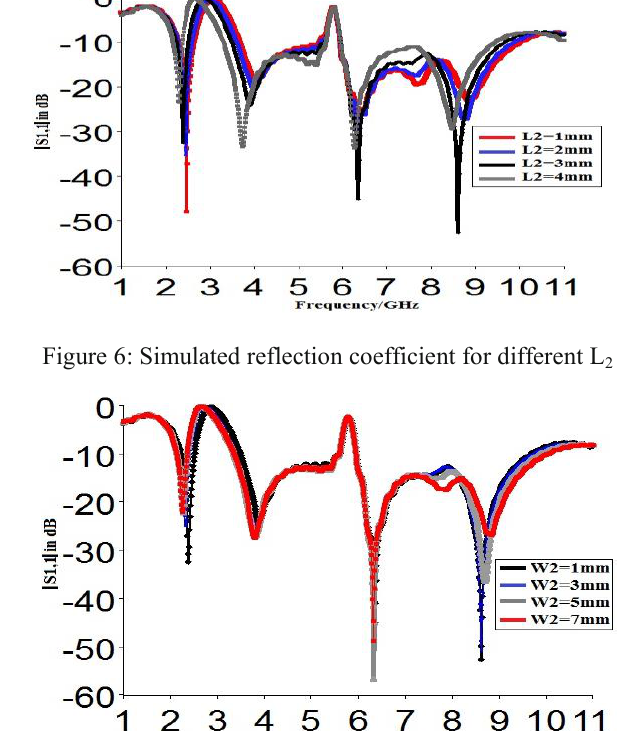
Table 2: Optimal parameters values of 𝛤 -shaped.